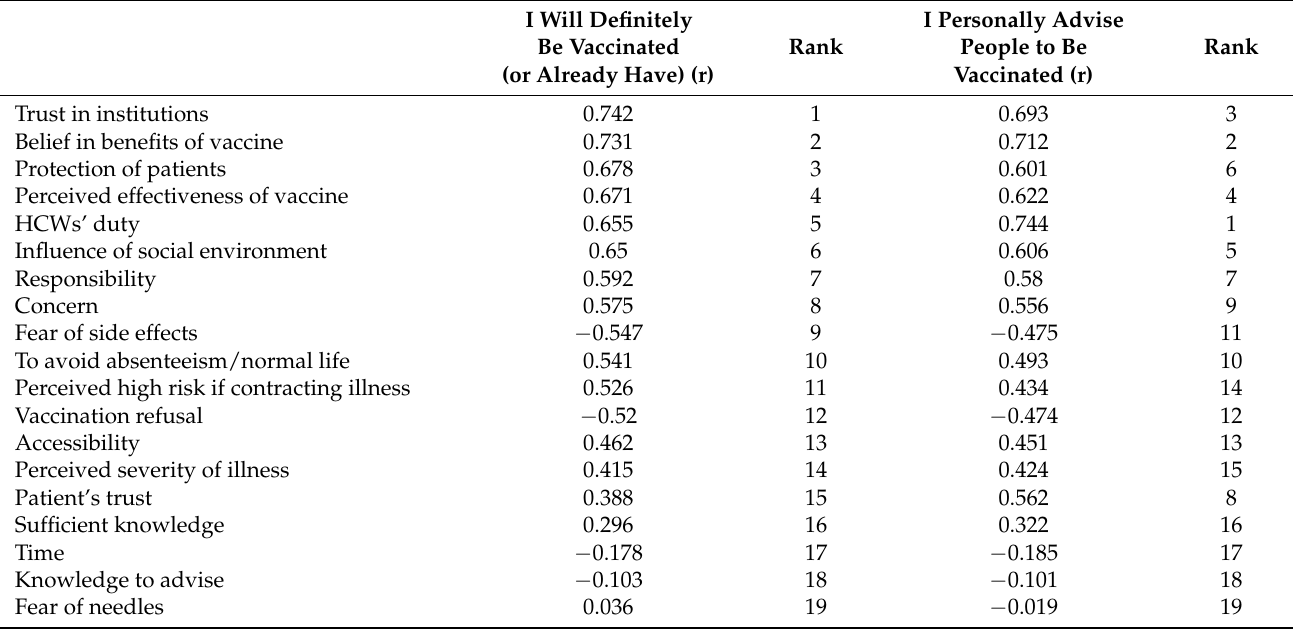
Table 4. Attitudes and beliefs associated with vaccination intention and advising vaccination (Spearman correlation coefficient)—sorted by the strength of an